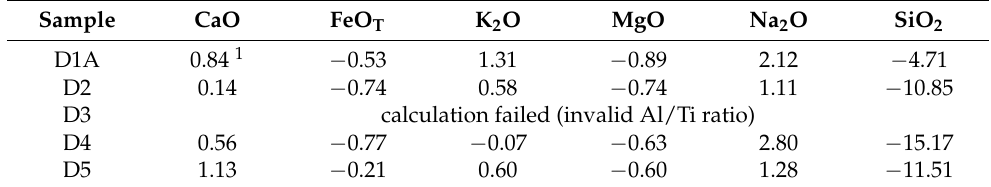
Table 2. Results of mass balance calculation provided in g per 100 g of precursor (absolute mass